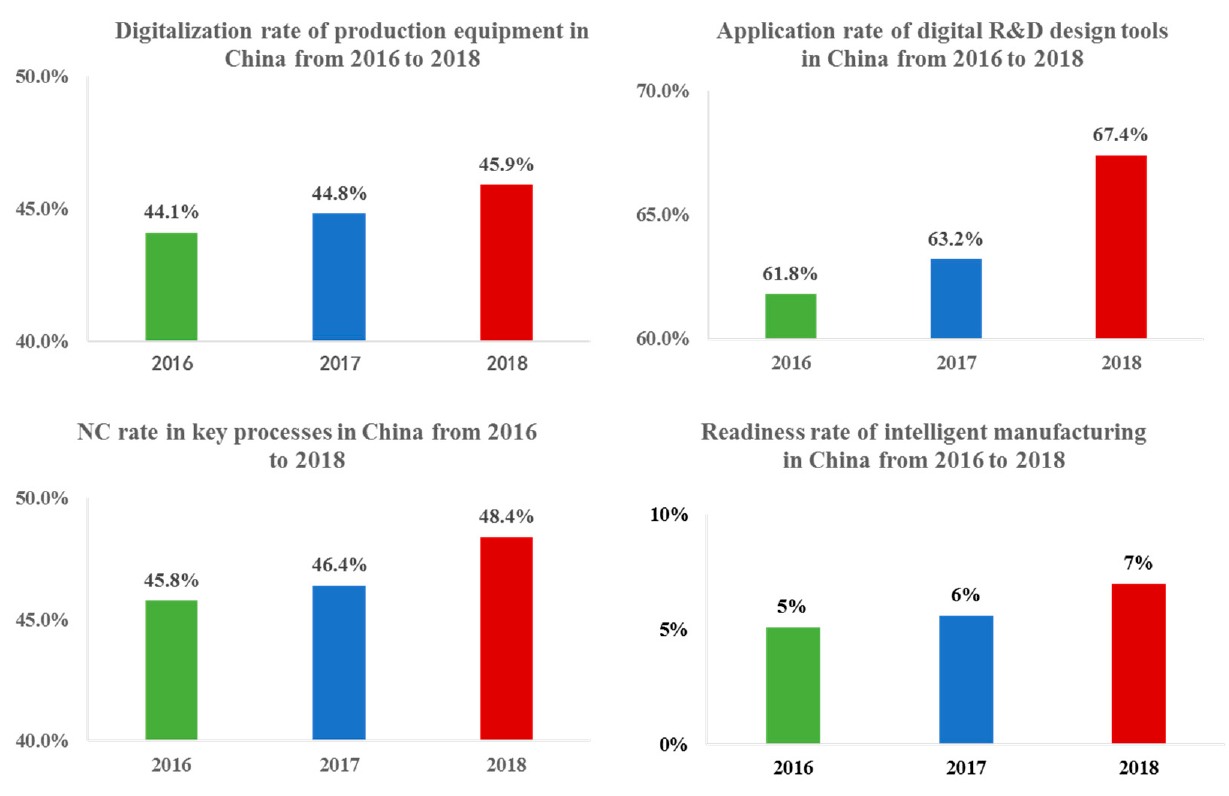
Figure 10. Key monitoring indexes of digital transformation in China.